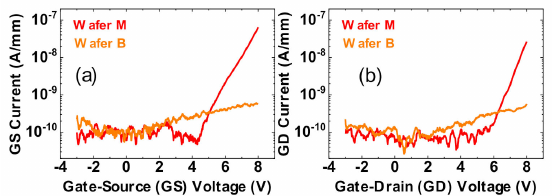
Figure 2. Comparison of diode leakage behavior between Wafer M (uni-layer oxide) and Wafer B (bilayer oxide). ( a , b ) are typical characteristics of the gate-source (GS) diode with drain floating ( a ) and the gate-drain (GD) diode with source floating ( b ).